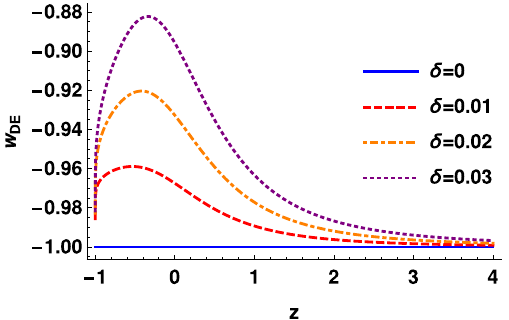
Fig. 5 The evolution of the effective dark energy equation-of-state parameter w DE , for different values of the new Tsallis entropy param- eter δ in (32), in the case of (cid:2) (cid:9)=